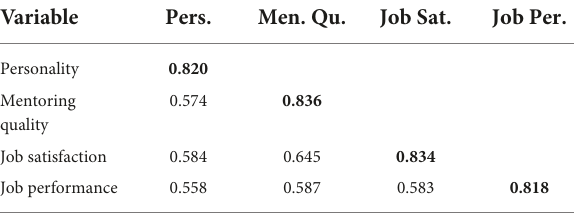
TABLE 3 Discriminant validity analysis. Variable Pers. Men. Qu. Job Sat. Job